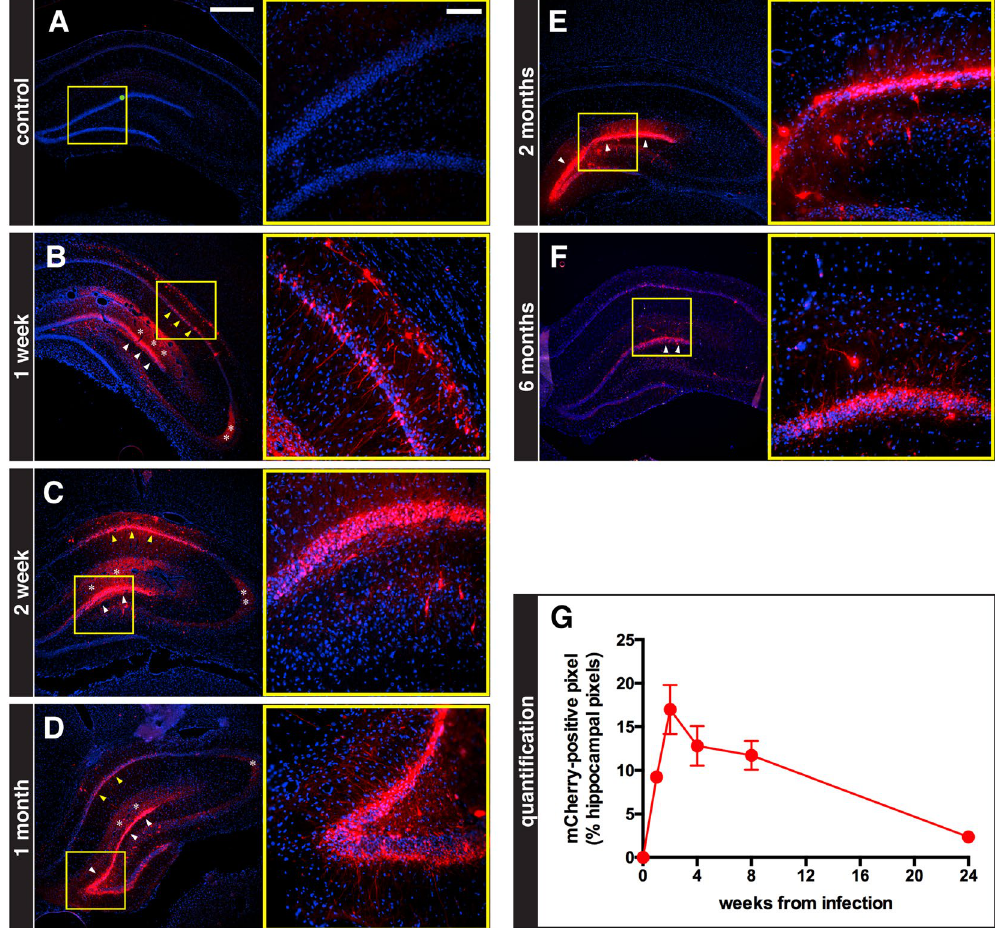
Figure 3. Time course of mCherry expression in the hippocampus. ( A – F ) Representative images (5 sections/animal, 4 animals/group) of coronal sections from animals killed at the indicated time-points after J Δ NI6 injection into the right hippocampus (see Materials and Methods for details). Left panels show low magnification images, right panels higher magnifications of the areas framed in yellow in the left panels. These sections were at an antero-posterior level immediately adjacent to the site of injection near the upper blade of the dentate gyrus granular layer (needle tip always located at the green spot shown in the left panel of (A). Native mCherry fluorescence in red; nuclei stained in blue with DAPI. Robust mCherry fluorescence is seen in dentate gyrus cells (white arrowheads) and in CA1 neurons (yellow arrowheads); a distinct mCherry signal can be observed in dendrites and axon terminals (white asterisks indicate dentate gyrus granule cell dendrites and terminals). Horizontal bar in ( A ) left panel (for all left panels) = 500 μ m; horizontal bar in ( A ) right panel (for all right panels) = 100 μ m. ( G ) Quantification of the time-course of native mCherry signal in the hippocampus. Data are the means ± s.e.m. of 4 animals per